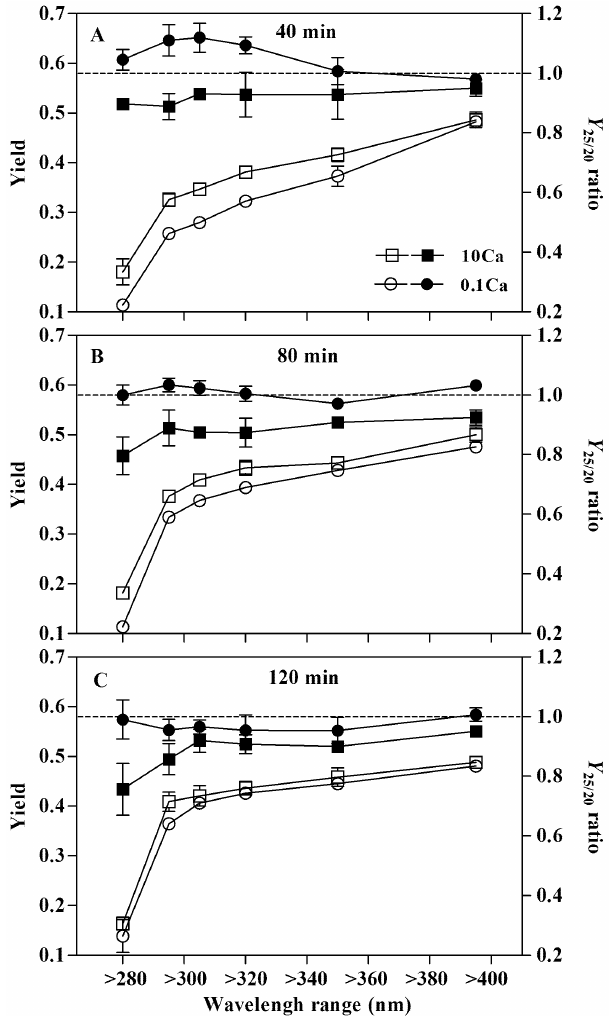
Fig. 2. Effective photochemical quantum yield ( F 0 v / F 0 m ) of Emilia- nia huxleyi cells grown at HCa (squares) and LCa (circles). Open symbols indicate F 0 v / F 0 m measured at 20 ◦ C whereas black symbols indicate the ratio of F 0 v / F 0 m measured at 25 ◦ C to that at 20 ◦ C. Mea- surements done after exposures to artificial radiation: (A) 40min, (B) 80min and, (C) 120min. The bars on top of the symbols repre- sent the standard deviation ( n =